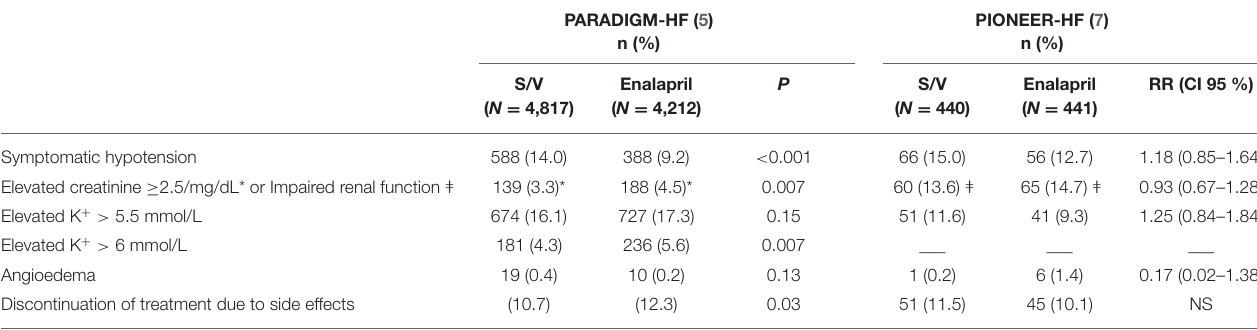
TABLE 1 | Side effects in the PARADIGM-HF and PIONEER-HF